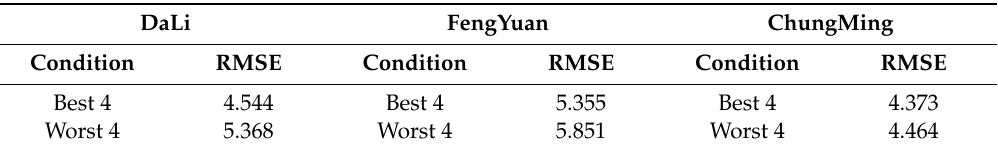
Table 4. Prediction results for three locations using the four most important and four least important features identified using the modified false nearest neighbor method